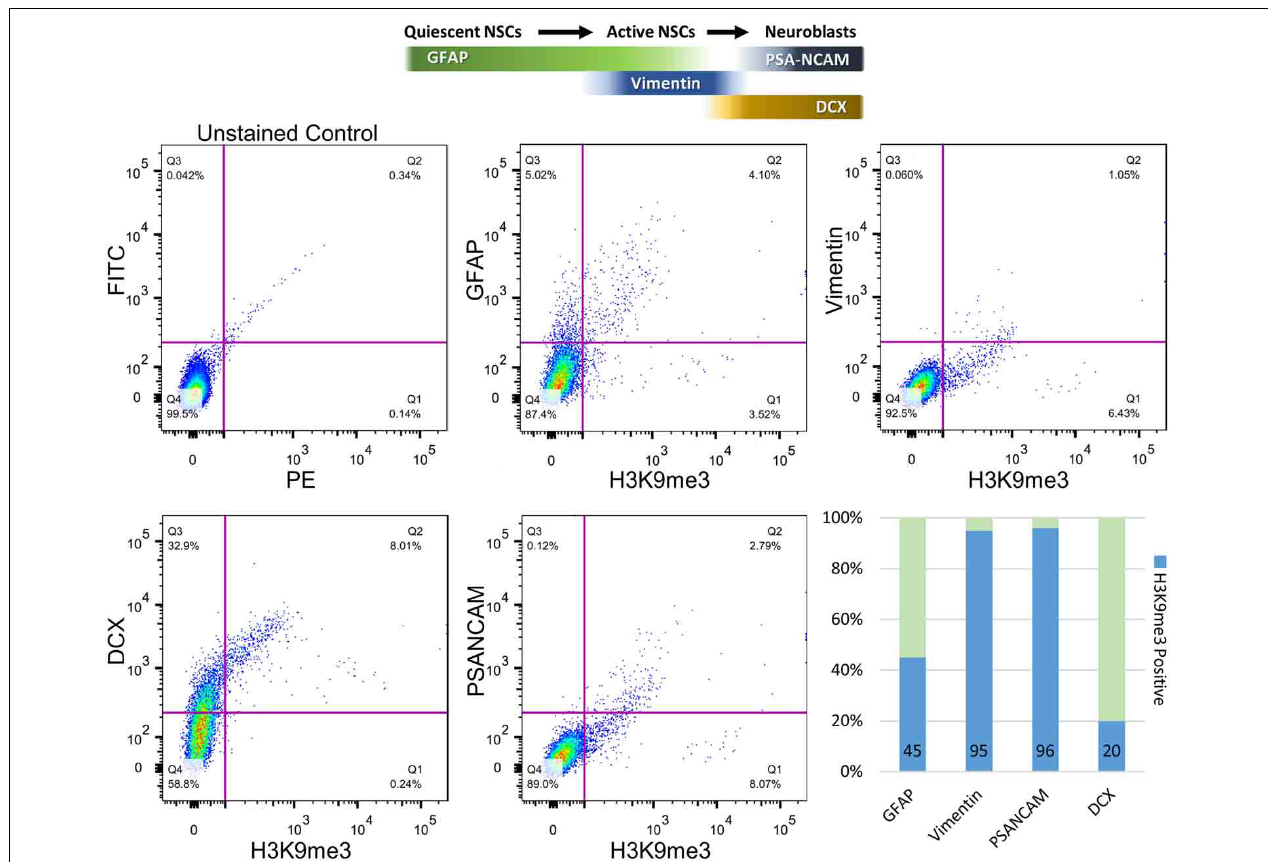
FIGURE 3 | Quantification of co-localization percentages between H3K9me3 and subpopulations of SVZ cells by flow cytometry. After SVZ dissection, dissociated cells were analyzed by flow cytometry with antibodies against H3K9me3 and cell-type markers including GFAP (quiescent and active NSC marker), Vimentin (relatively active NSCs),